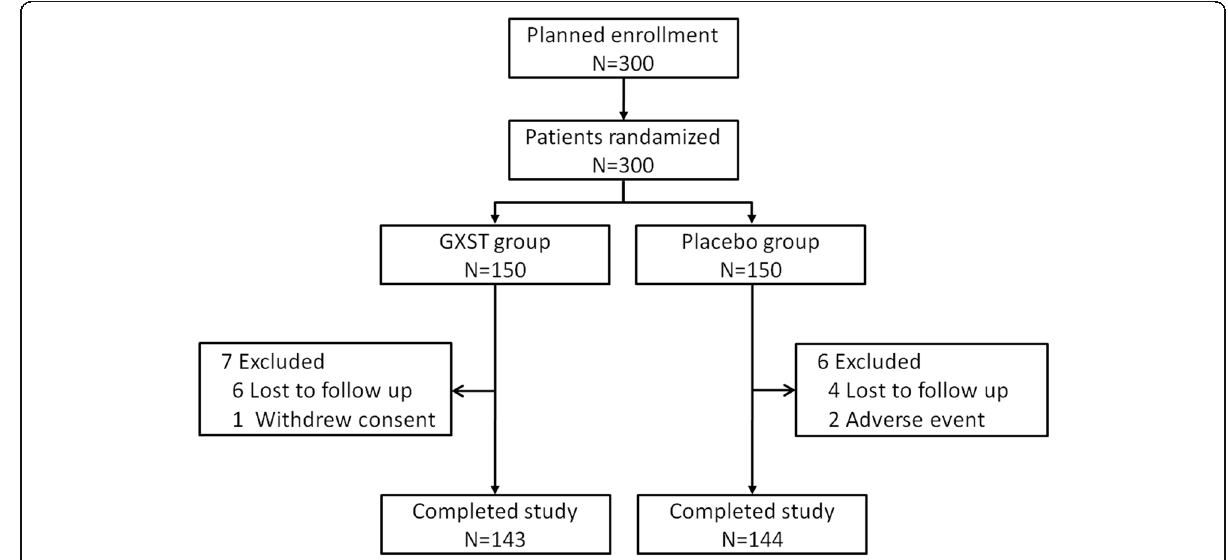
Fig. 2 Diagram of patient flow in the trial. GXST = guanxinshutong